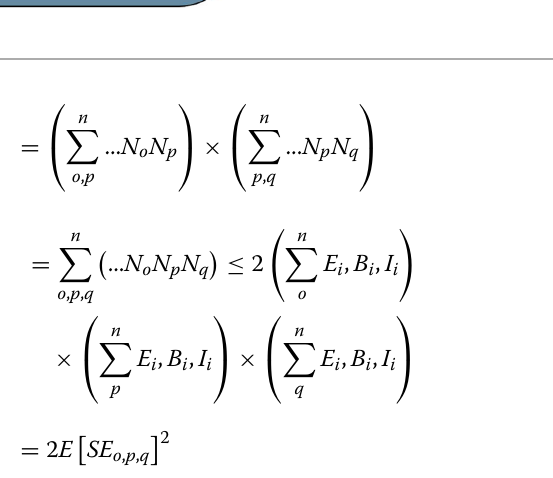
(cid:5) (cid:4) , i i × n q